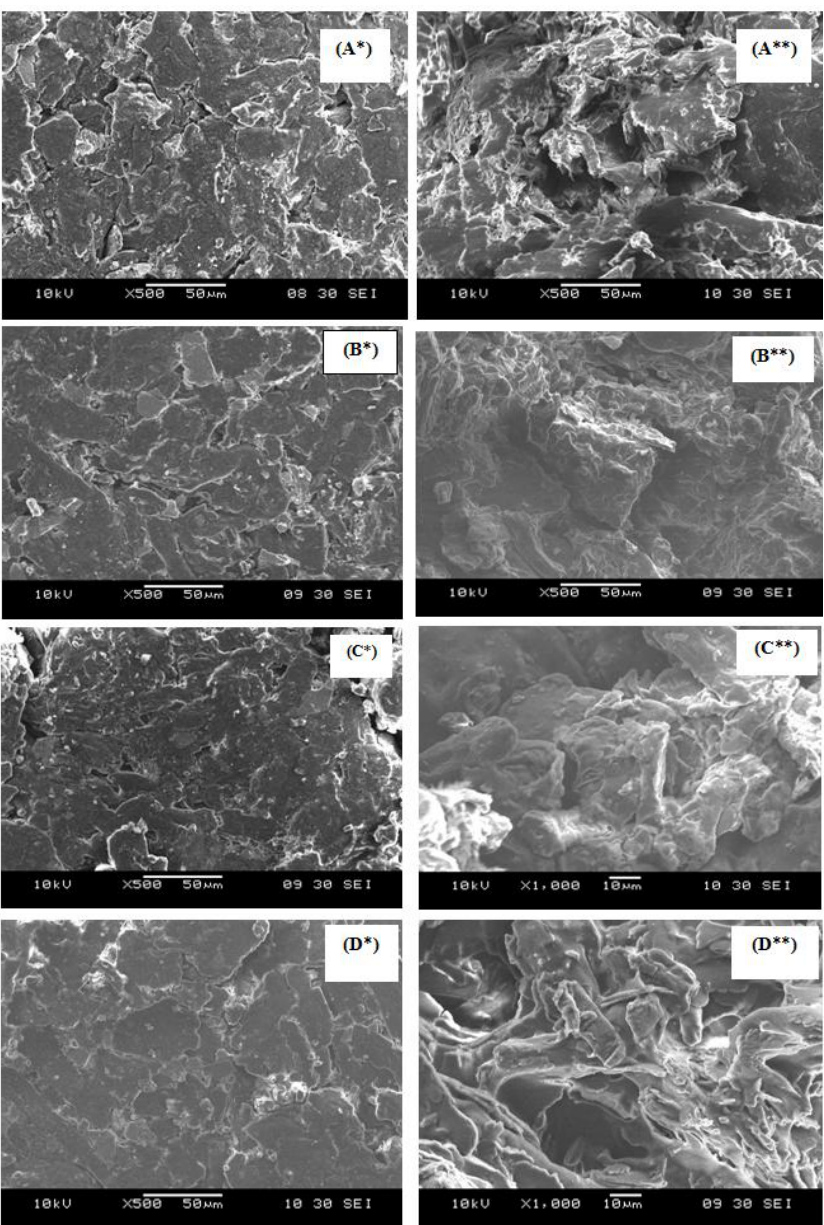
Figure 6. SEM photomicrographs of hydrogel matrix tablets G2 (A), G4 (B), G5 (C) and G6 (D) before (*) and after (**) the dissolution